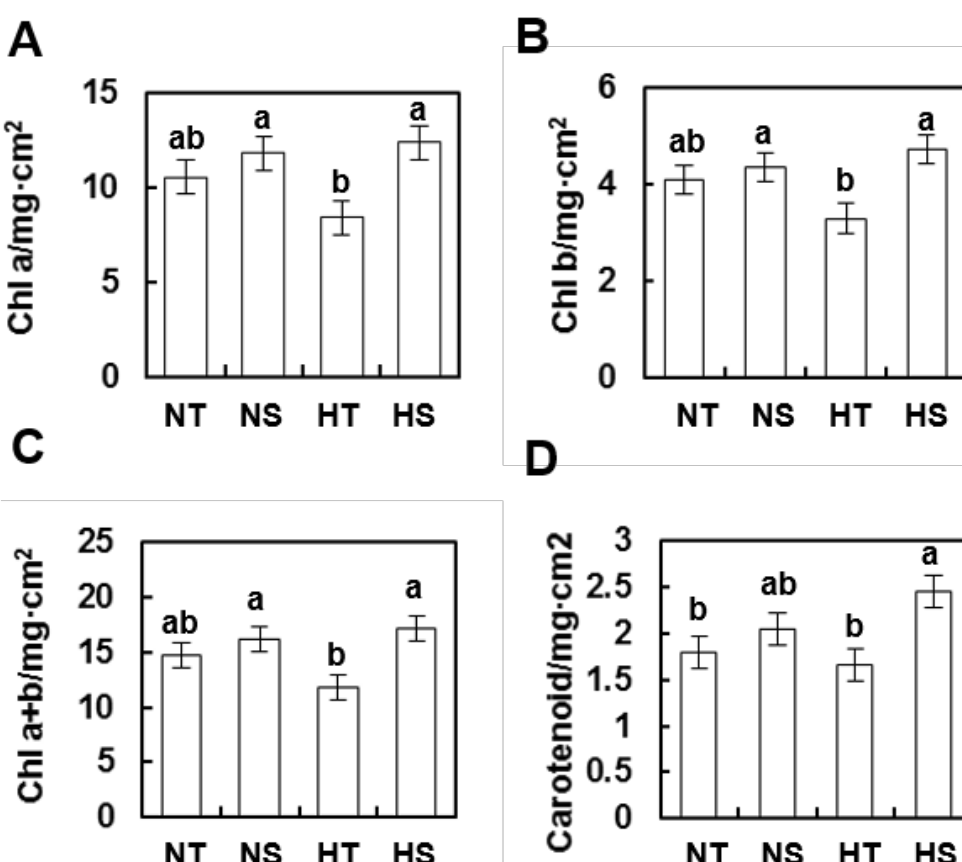
Figure 4. Photosynthetic pigments of tomato plants growing under normal conditions or high temperature, with or without exogenous application of Spd(( A ) is Chl a, ( B ) is Chl b, ( C ) is Chl a+b, ( D ) is carotenold). Error bars represent the SDs among three independent experiments. Note: Different letters represent significant differences with p < 0.05 (Duncan’s multiple range tests). NT, normal growth condition under 25/18 ◦ C and water; NS, normal growth condition under 25/18 ◦ C with 1 mM Spd treatment on plants; HT, high temperature growth condition on 38/28 ◦ C and water treatment; HS, high temperature growth condition on 38/28 ◦ C with 1 mM Spd treatment on leaves.